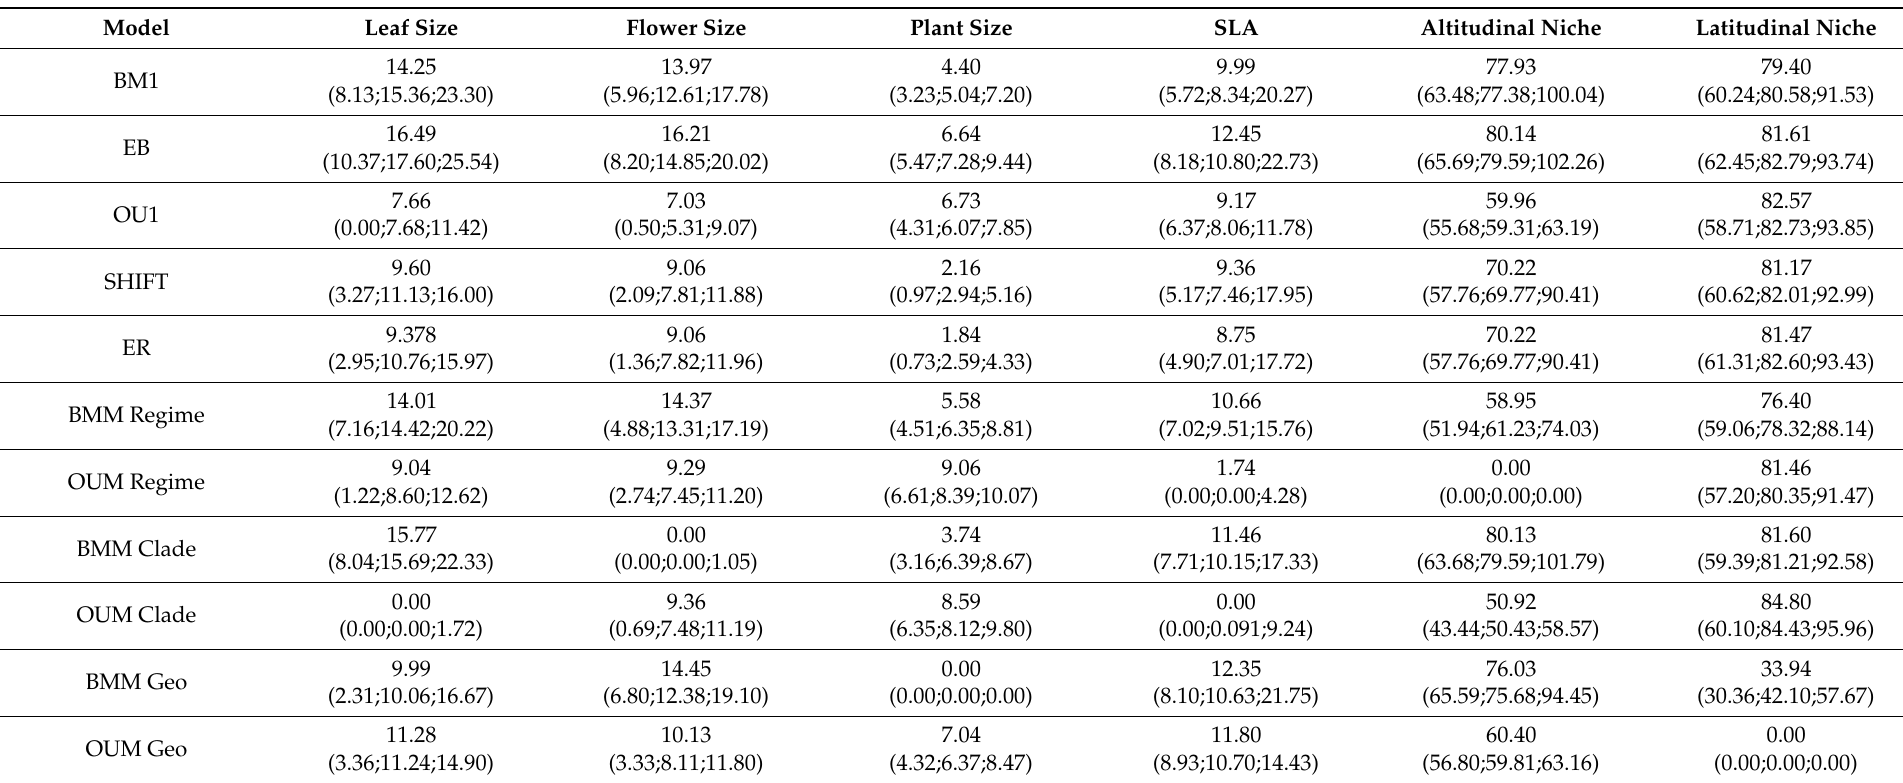
Table 3. Results from the model comparison analyses of the evolution of the 6 traits investigated in the study. Values displayed are ∆ AICc estimated from the MCC tree together with the 10%, 50% and 90% quantiles (in parenthesis) of the distribution of ∆ AICc estimated from the posterior distribution of trees (100 trees). We ask the reader to refer to the main text for a detailed explanation of the 11 models compared. For each trait, the model(s) that obtain the best fit is (are) in